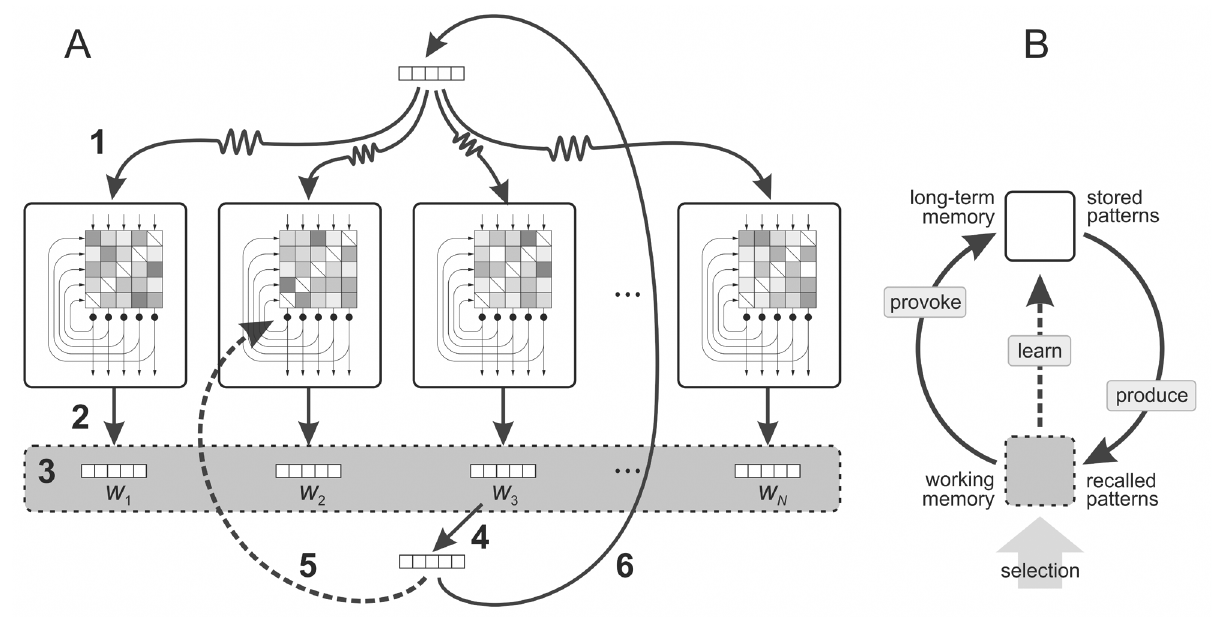
Figure 1. A) Architecture of multiple attractor networks performing Darwinian search. Boxed units are attractor networks. Each network consists of N neurons ( N = 5 in the figure, represented as black dots). Each neuron receives input from the top (1) and generates output